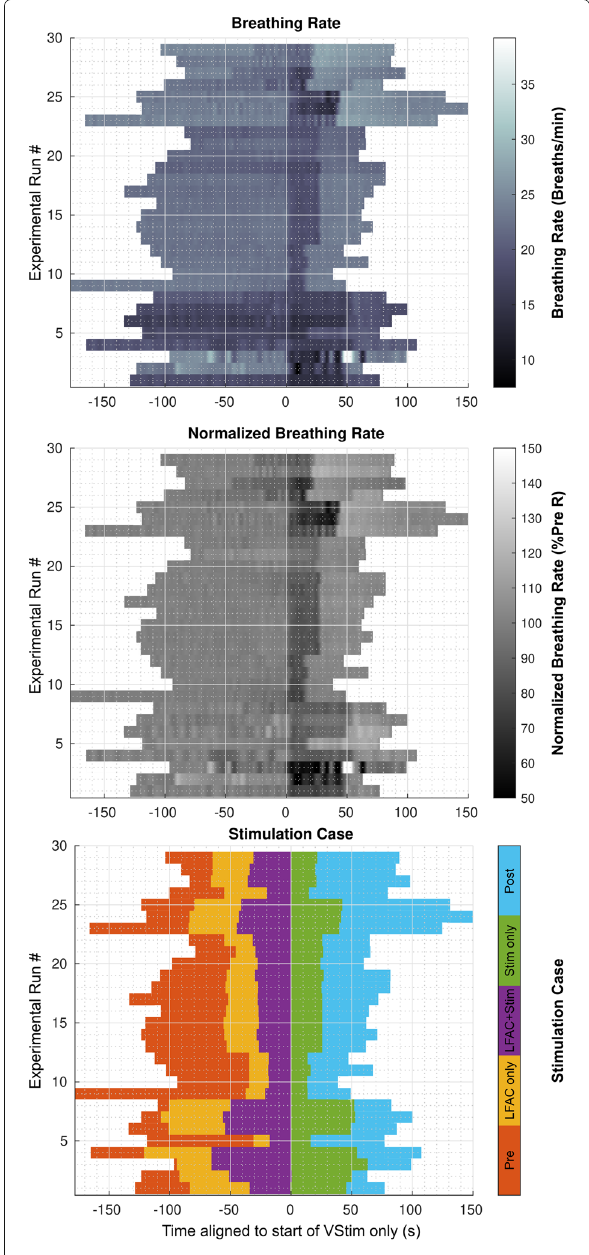
Fig. 4 Temporal raster plots of the continuous breathing rate (Top), and normalized breathing rate (Middle) records as a function of stimulation case (Bottom) for all experimental runs across all animals (N=30). Times were aligned to the start of the ’Stim Only’ epoch to show the transition between the breathing rate during LFAC + vagal stim and vagal stimulation only, which shows a drop in breathing rate when LFAC is removed. Top panel’s breathing rate is the instantaneous rate calculated using the instantaneous interval between inspirations. The middle panel shows the instantaneous breathing rate normalized to the average ’Pre’ epoch breathing rate. Middle panel shows the experimental normalized breathing rate percentage with respect to the averaged breathing rate in ‘pre’ epoch. Bottom panel shows the times when of each stimulation cases were